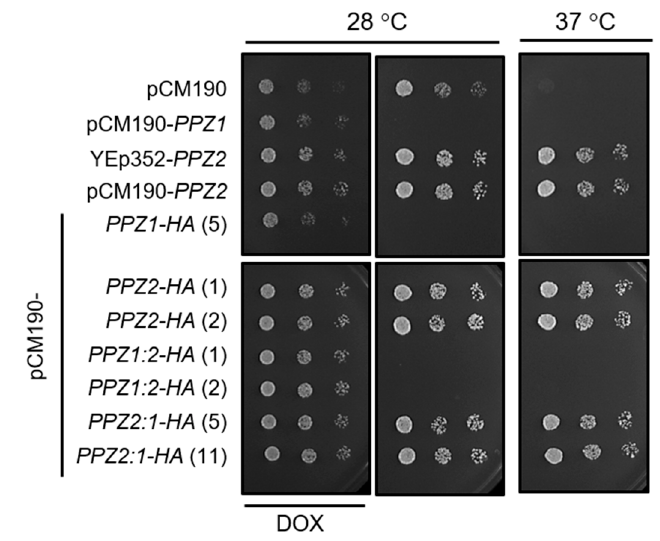
Figure 3. Expression of Ppz2 and Ppz2:1 counteract the heat-sensitive phenotype of Ppz-deficient cells. Strain AGS19 ( ppz1 ppz2 ) was transformed with the indicated plasmids. Cultures were spotted, as described for Figure 2A, and plates were incubated for 48 h at the indicated temperatures.